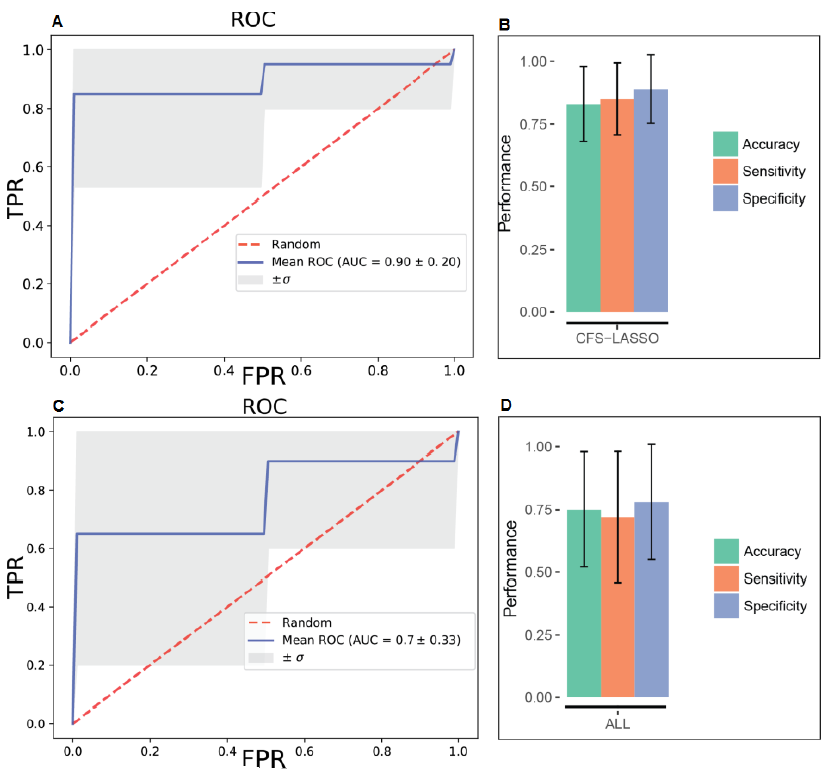
Figure 1. Receiver operating characteristic (ROC) curves for support vector machine (SVM) models built on all metabolite concentration values and the top five metabolites selected by both CFS and LASSO variable selection algorithms, respectively ( A and C ) and corresponding performance metrics ( B and D ). FPR—false positive rate; TPR—true positive rate.